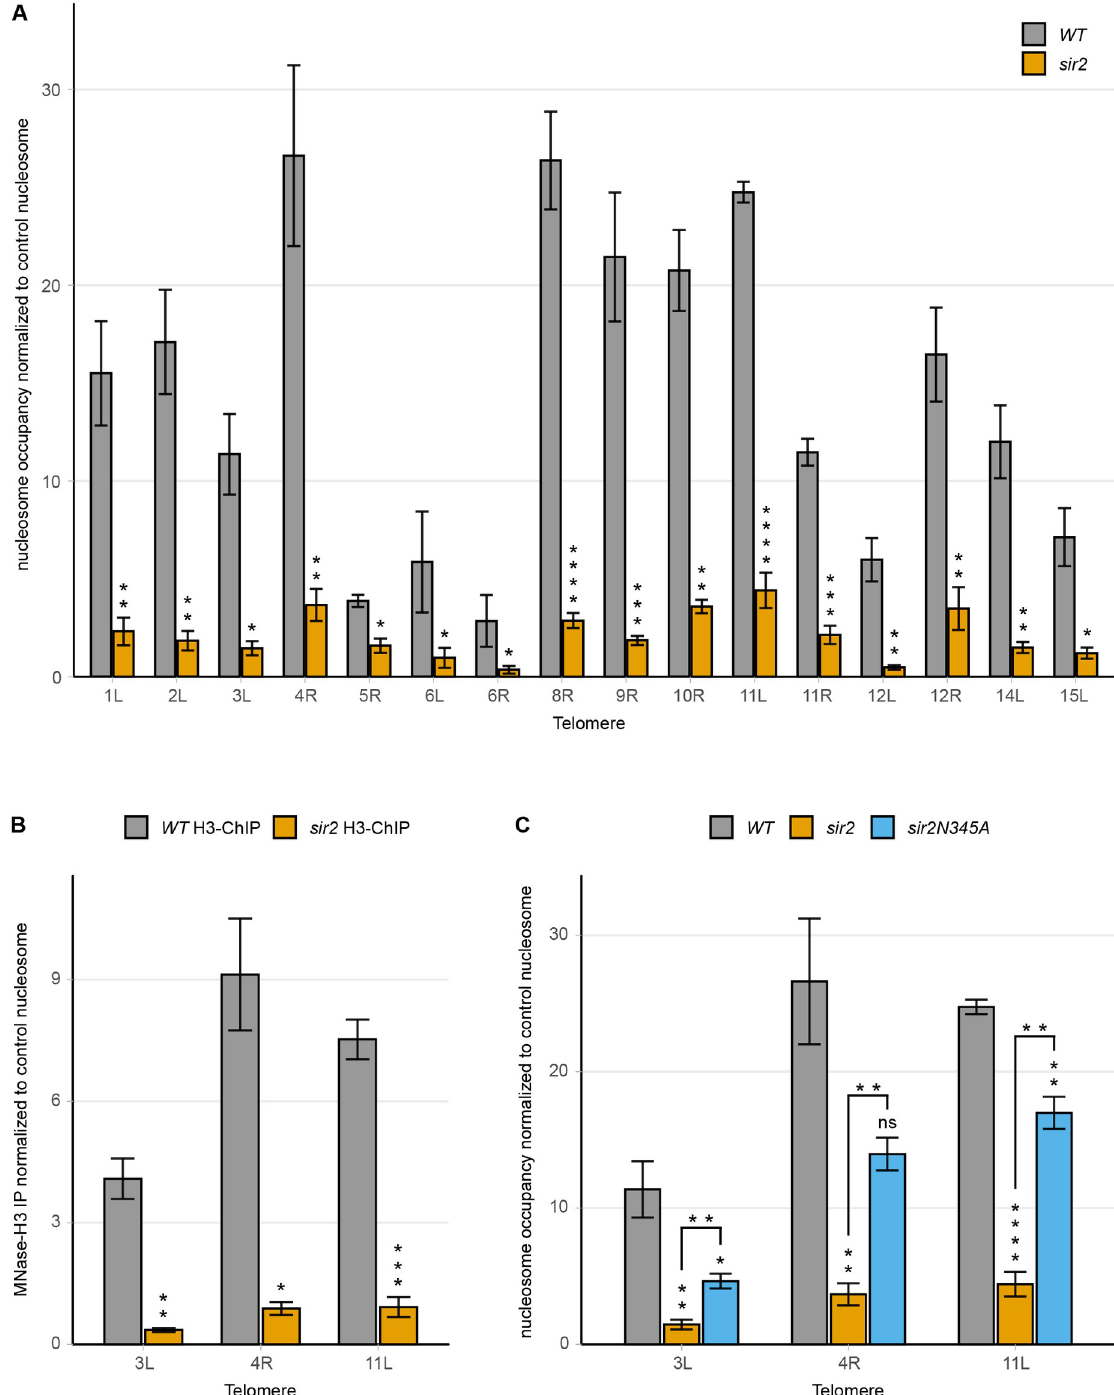
Fig 2. Sir2 stabilizes a nucleosome in the X-elements. ( A ) MNase-qPCR of the STR-D region of 16 telomere ends in WT and sir2 strains. ( B ) MNase-H3-ChIP-qPCR of WT and sir2 strains at the STR-D loci of TEL3L, 4R and 11L. ( C ) MNase-qPCR of the indicated STR-D loci in WT , sir2 and sir2N345A strains. All data are shown as mean ± SEM (n = 3, � p < 0.05, �� p < 0.01, ��� p < 0.001, ���� p < 0.0001, ns = not significant).